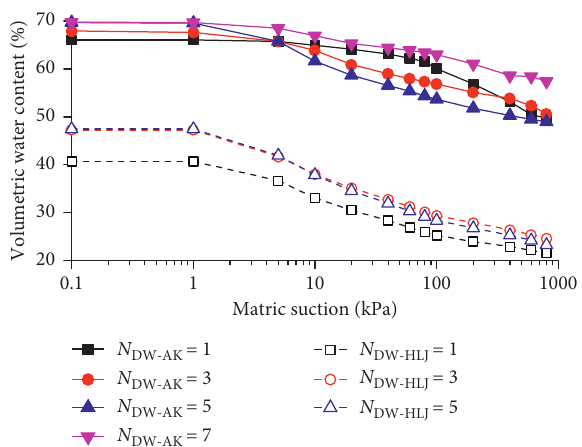
Figure 7: The SWCCs under different times of the dry-wet